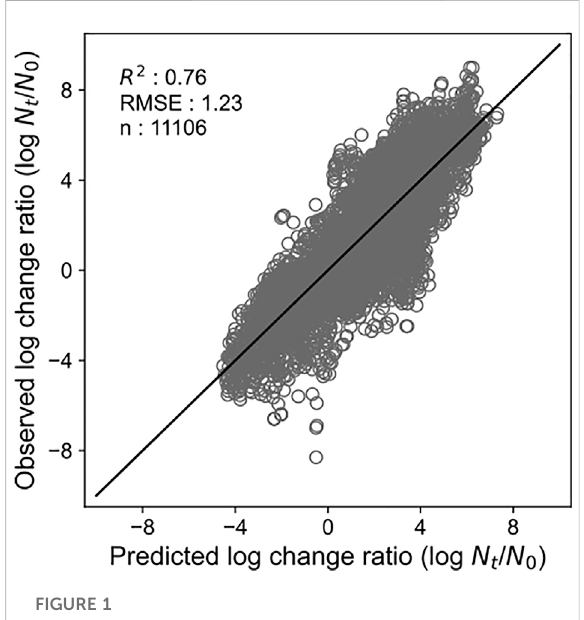
FIGURE 1 Comparison of the predicted and observed log change ratio for all the test data. The solid line represents residuals =